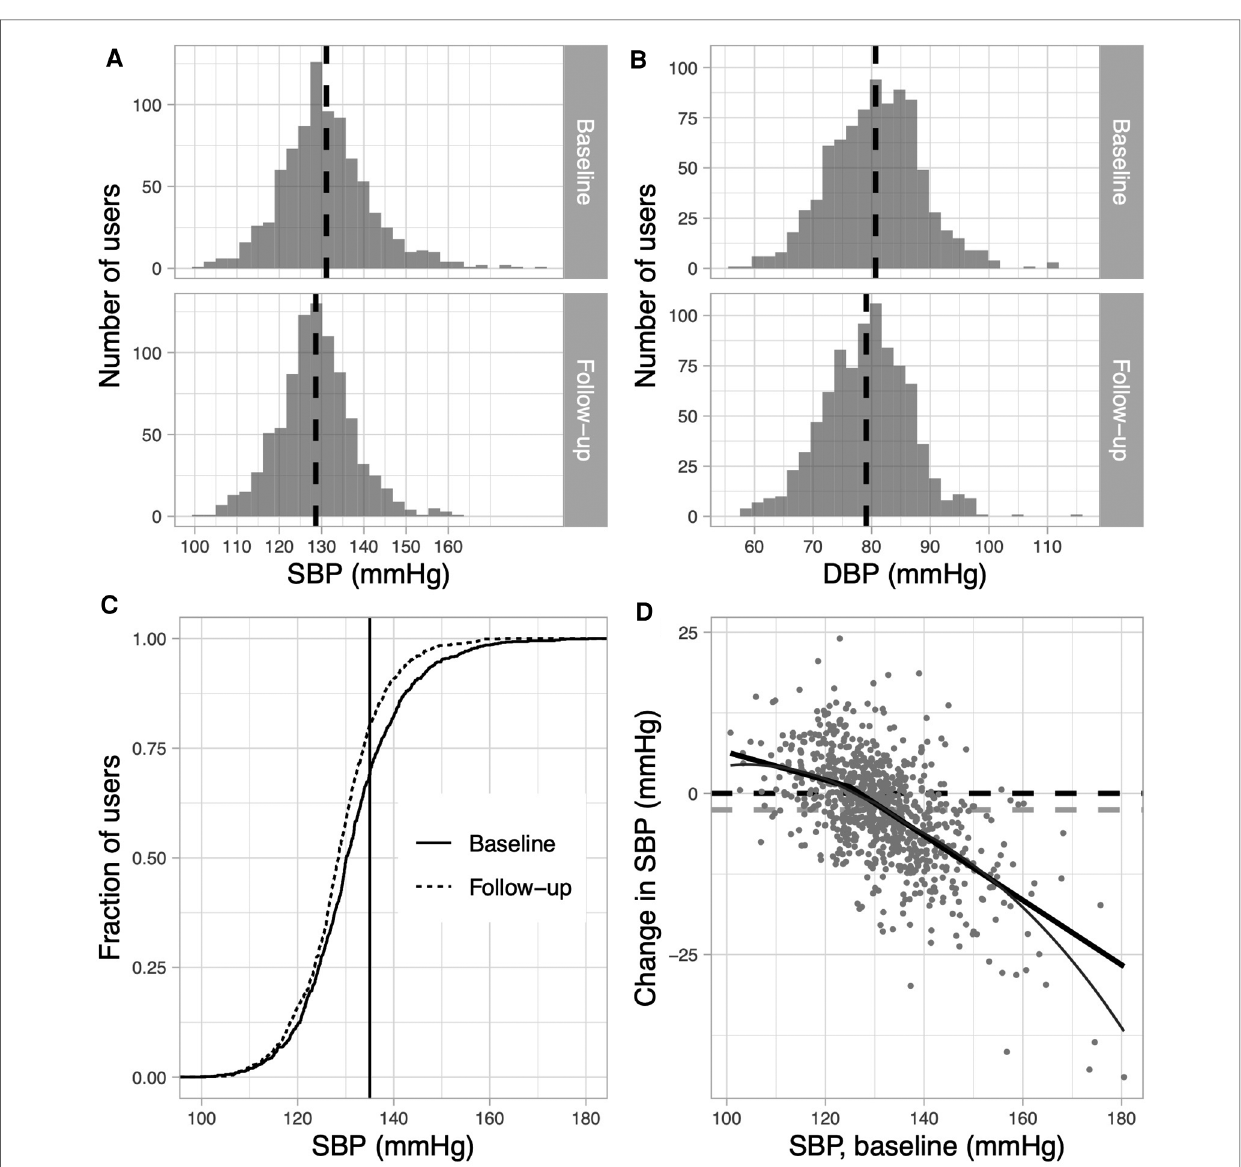
FIGURE 4 Blood pressure values and BP control at baseline and during follow-up. (A+B) Distribution of absolute systolic ( A ) and diastolic ( B ) BP- values at baseline and at follow-up. The dashed-line indicates the mean BP. ( C ) Fraction of patients by SBP (mean of entire HBPM period) at baseline (solid) and at follow-up (dashed). The vertical line indicates 135 mmHg; the threshold for diagnosing HT. ( D ) Change in SBP at follow-up according to baseline SBP: solid line indicates steady linear fi tting of data. Thin grey line is a LOESS based guide-to-the-eye to visualise the non-linear relationship approximated by a piecewise linear model (bold solid line). The horizontal dashed line (grey) represents the average decrease in SBP. All analyses are based on data obtained from users with self-reported hypertension, who completed a HBPM-period at baseline and follow-up ( n